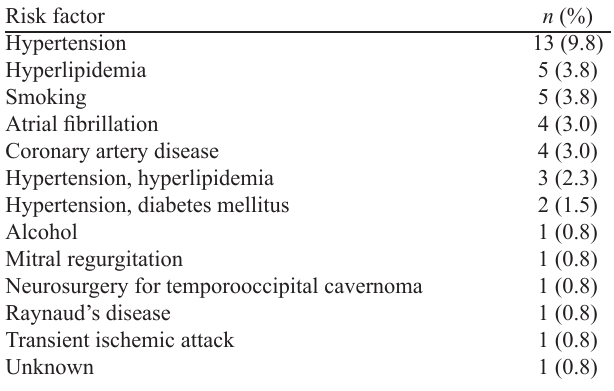
Table 2. Predisposing risk factors of stroke.